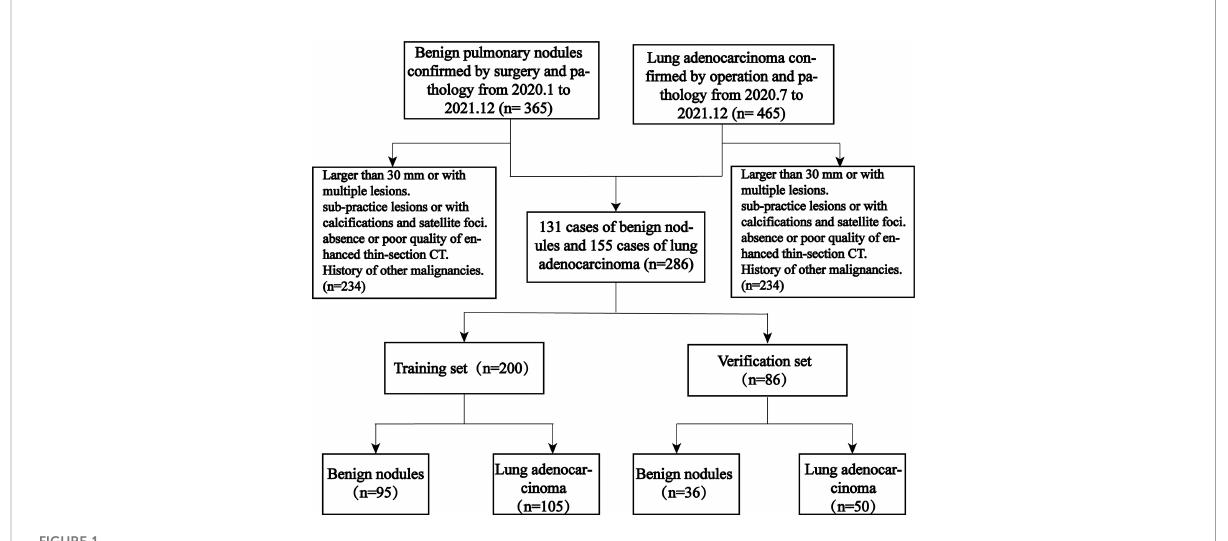
FIGURE 1 Patient stowage fl owchart divided into training and validation sets at a ratio of